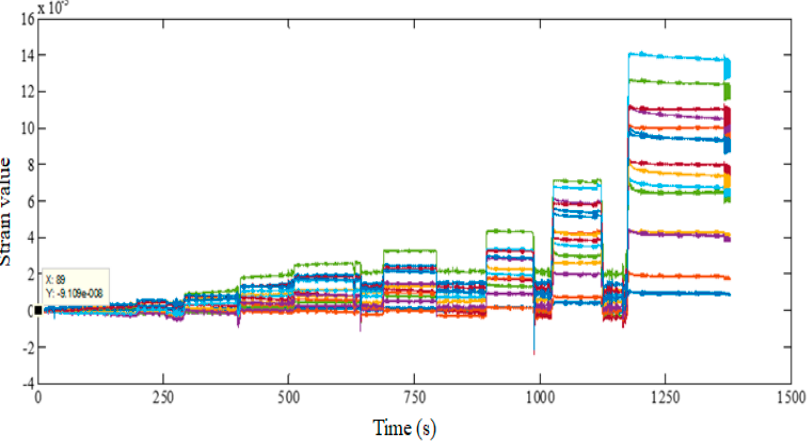
Figure 13. Change of strain with time at the point of fiber Bragg grating.